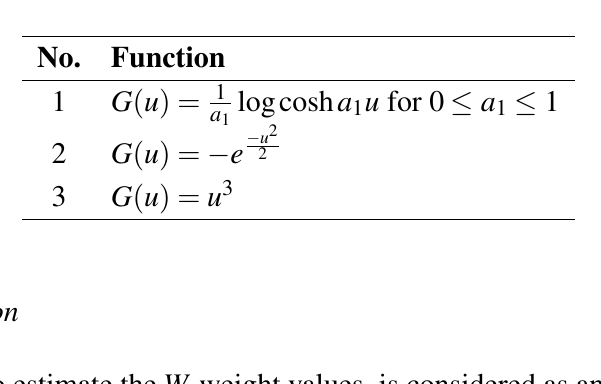
Table 2. Common estimator functions G for a neg-entropy